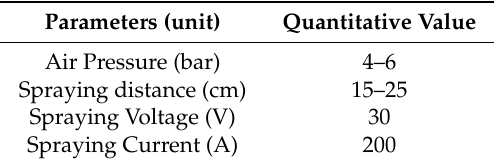
Table 2. Detail parameters used in the high frequency arc thermal metal spray process [16–18].